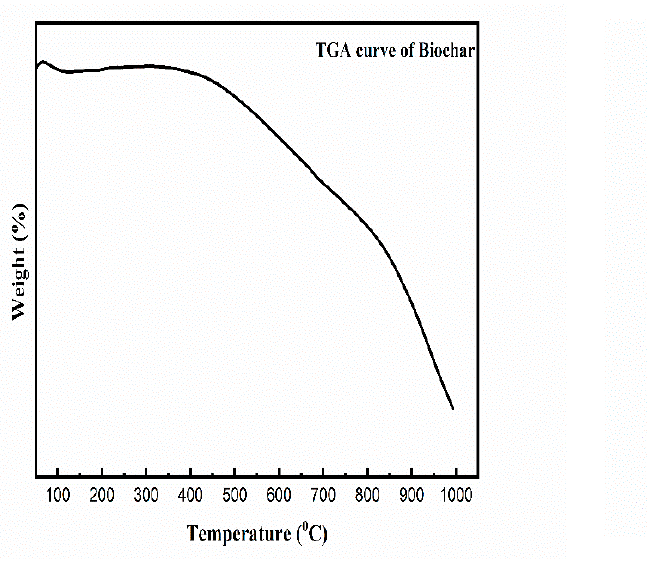
Figure 4. FTIR spectrum of MB-ZnO nanocomposites.